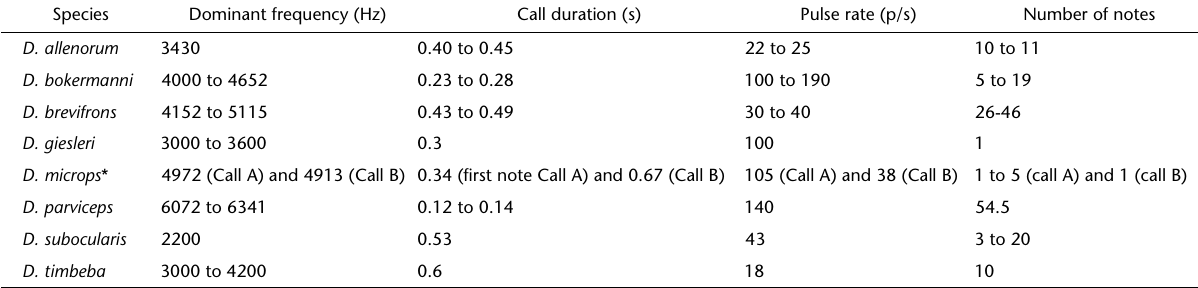
Table 3. Acoustic properties of the advertisement call of some species of Dendropsophus parviceps group. The complementary data come from D UELLMAN & C RUMP (1974), H EYER (1980), M ARTINS & C ARDOSO (1987), O RRICO et al. (2013).